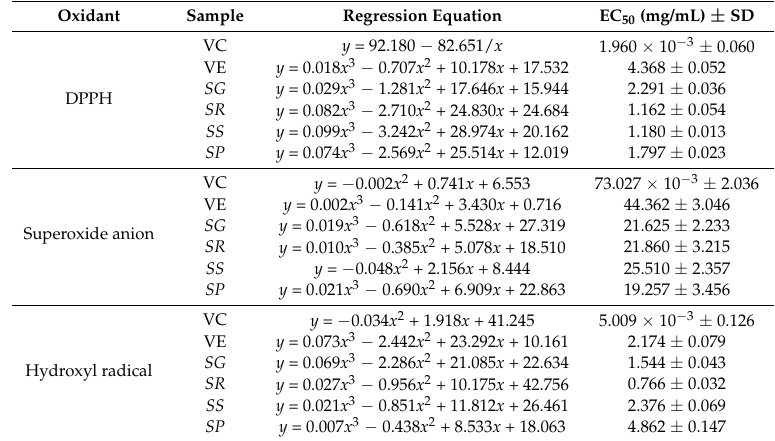
Table 3. The results for free radical scavenging of four species.